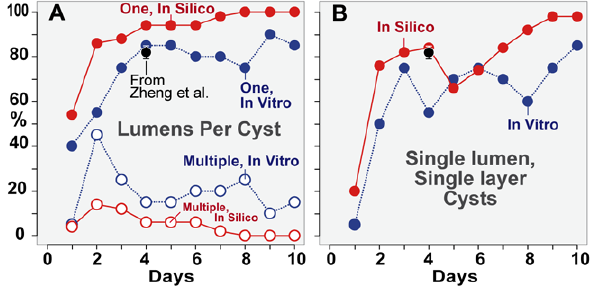
Figure 3. Percentage of cysts with different numbers of lumens. (A) Percentage of cysts that have single (solid circle) or multiple (open circle) lumens. (B) Percentage of SLSL (single-layer, single-lumen) cysts. Blue: in vitro data for 20 cysts taken each day for ten days. Red: in silico data for 50 CYSTS using parameters values from Table 2. Black: mean and standard deviation for ‘‘normal’’ MDCK cysts observed by Zheng et al. [6] as described in the text. Solid lines represent continuous growth of ISMA CYSTS . Dotted lines represent discrete growth of MDCK cysts.